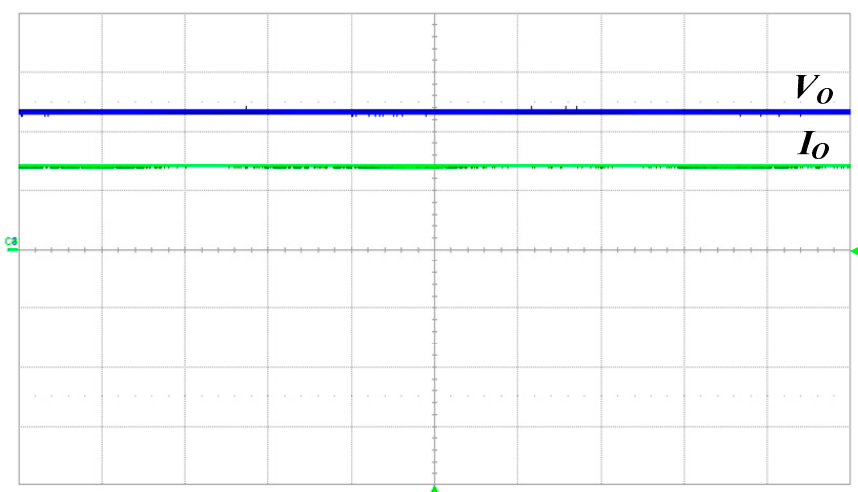
Figure 12. Measured output current I O (0.5 A/div) and voltage V O (100 V/div); time scale: 2 ms/div.